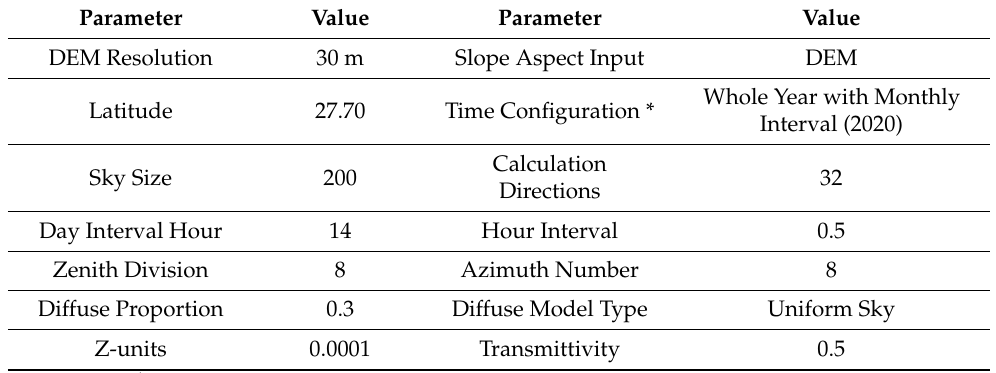
Table 1. Parameters for area solar radiation tool [29] (Default values used unless otherwise stated).